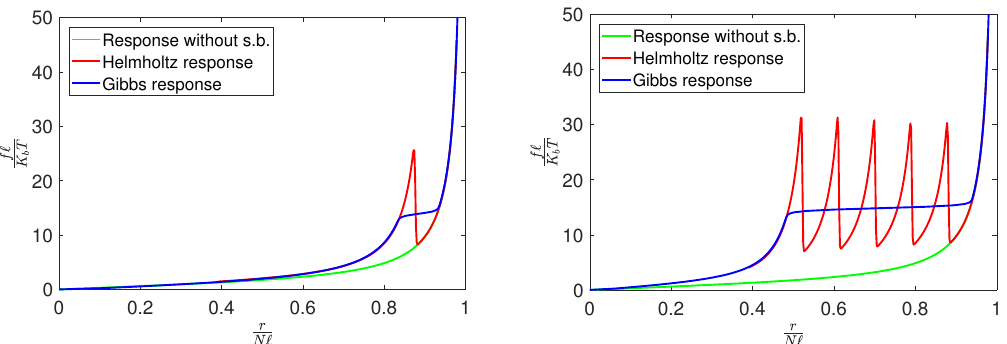
Figure 4. Force–extension response of a chain with only one sacrificial bond (left panel) and with s = 5 sacrificial bonds (right panel) under both Gibbs (blue curves) and Helmholtz (red curves) conditions. We also added the response of the same system without sacrificial bonds in order to compare the different behaviors (green curves). The plots are represented with adimensional quantities. We adopted the parameters N = 50, h / k = 1, d / (cid:96) = 1/10, n = 5 and E / ( K b T ) = 75 for all sacrificial bonds.